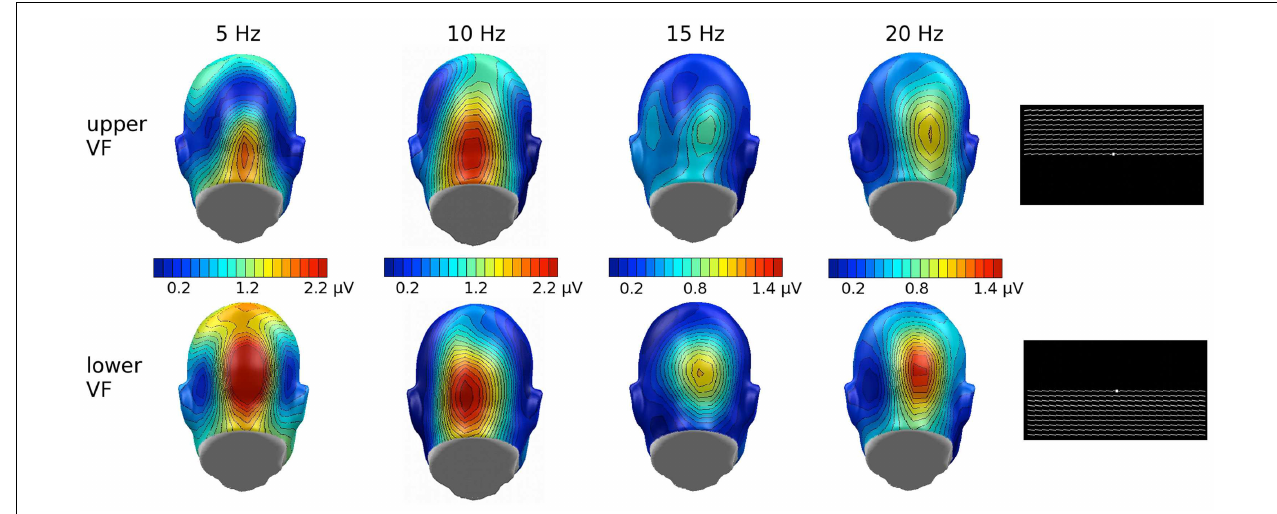
FIGURE 7 | Grand mean ( n = 9) scalp topographies of the ssVEP response to the individual driving frequencies, in the upper and lower visual field (VF). Overall lowerVF showed enhanced ssVEP amplitude and, relevant to the current study, no frequency-dependency found in this additional study.